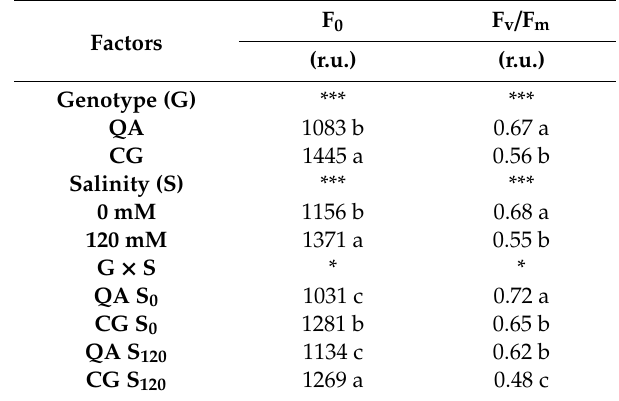
are not significantly di ff erent according to Duncan’s post hoc test ( p < 0.05).